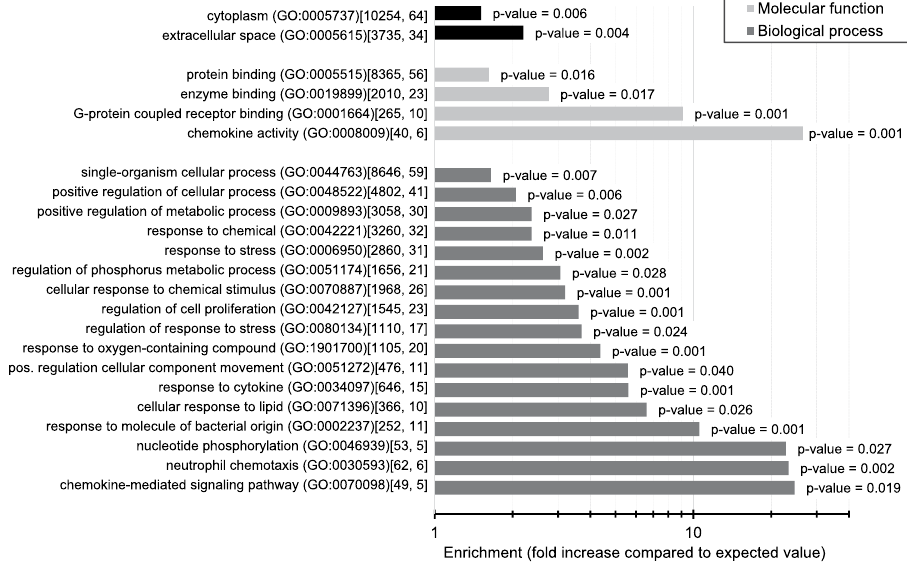
Figure 2. Summary of GO terms significantly enriched ( p -value < 0.05) in the mouse proteins encoded by genes differentially expressed in response to fluid flow. The analysis was peformed using the PANTHER system 67 separately for each of the three classes of GO terms: molecular functions, biological processes and cellular component (subcellular location). Horizontal bars show the value of enrichment, defined as the fold increase when compared to the expected value measured on the mouse proteome, and the corresponding p -values are given next to the bars. The number of each GO term occurence in the mouse proteome and among the proteins encoded by differentially expressed genes is given inside the square brackets. We only consider GO terms that occur at least five time and for which the enrichment is greater than 150% and p -value <